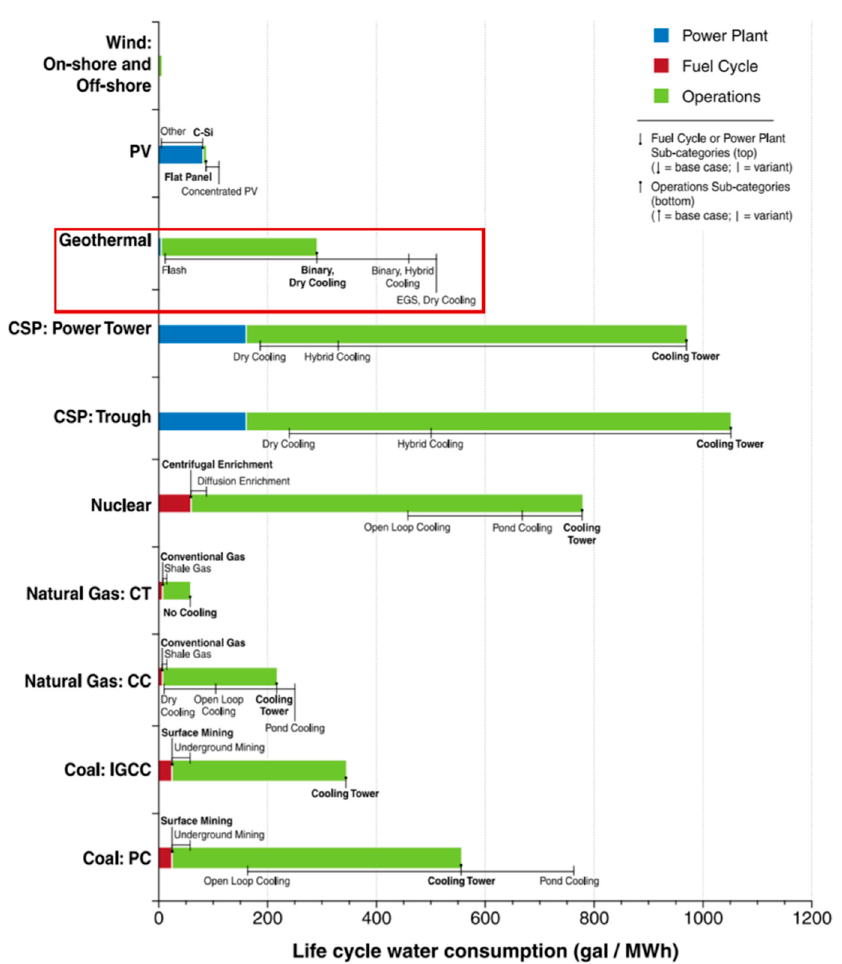
Figure 12. Estimated life cycle water consumption factors for selected electricity generation technologies, based on median harmonized estimates, demonstrate significant variability with respect to technology choices [54].